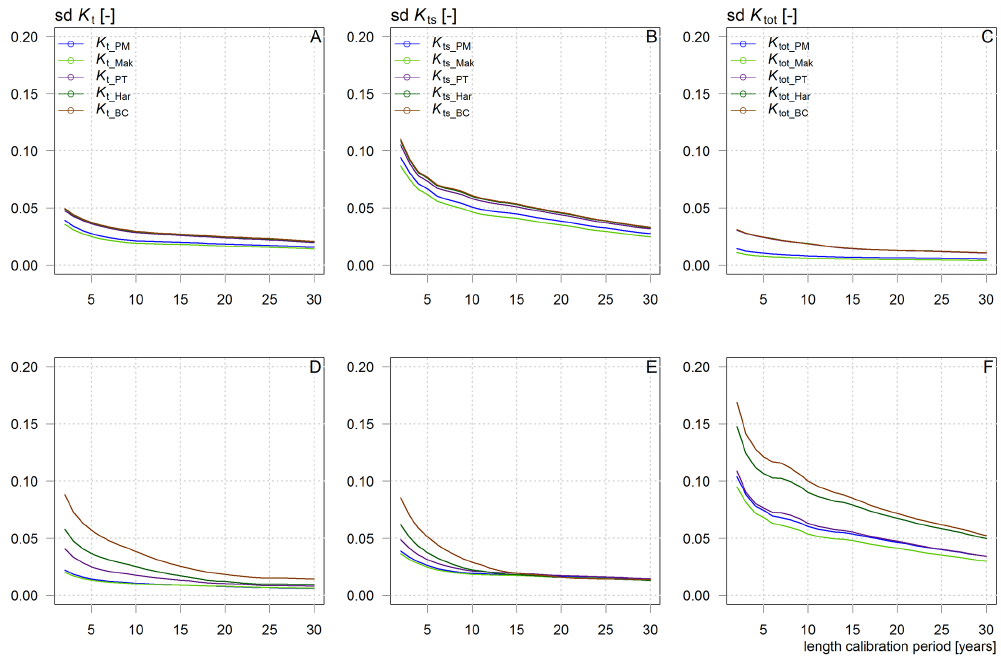
Figure 8. Standard deviation (SD) for K t (a, d) , K ts (b, e) and K tot (c, f) normalized to their mean values, for heather (a–c) and spruce (d–f) , as a function of the length of the calibration period. K values are derived for each E ref method; K and E ref are calibrated on the same periods.